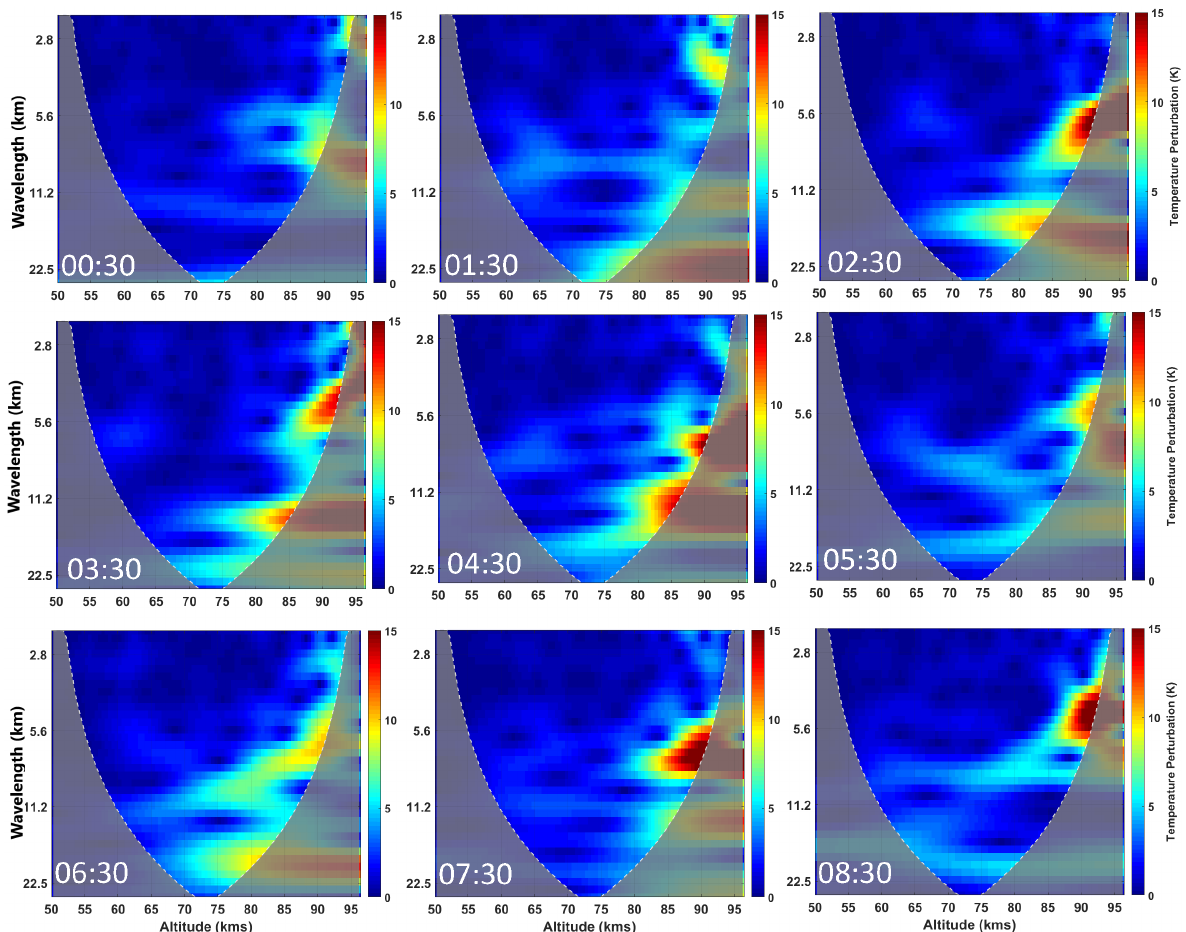
Figure 11. Continuous Morlet wavelet transform of the lidar temperature perturbations on the night of D+0. Scalograms are given at hourly intervals and represent vertical wavelength as a function of